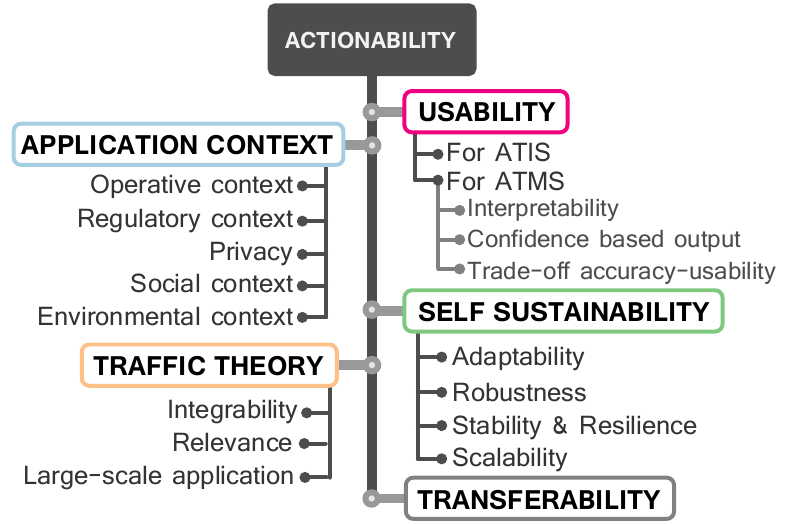
Figure 2. Functional requirements for actionable data-based models in Intelligent Transportation Systems (ITS). ATIS: Advanced Traveler Information Systems; ATMS: Advanced Transportation Management